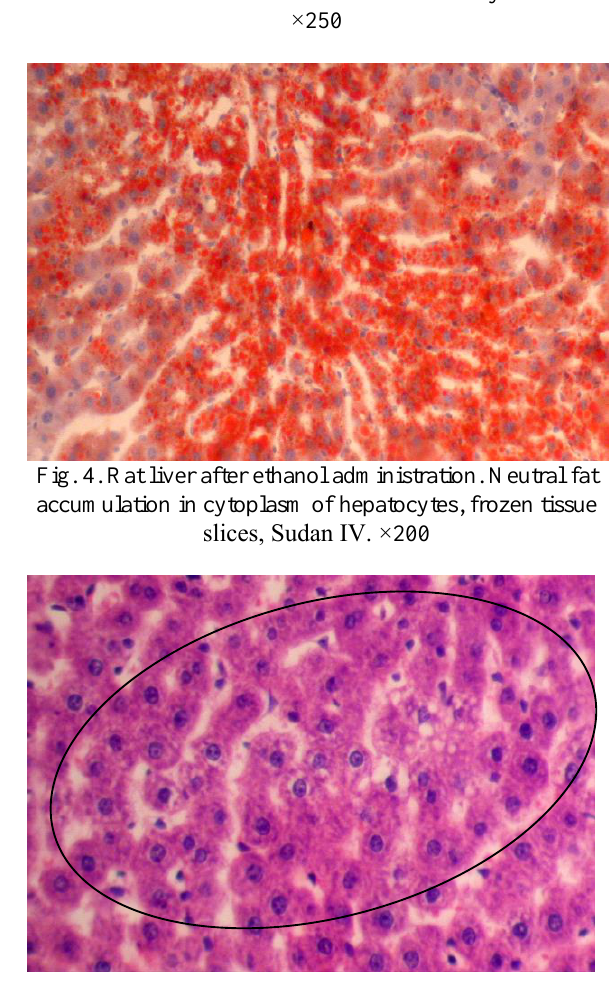
Fig. 5. Rat liver, which on the background of ethyl alcohol was treated by plum fruit fibers. Fractal-focal character of vacuolization of hepatocytes against the background of unchanged parenchyma. Hematoxylin-eosin ×300